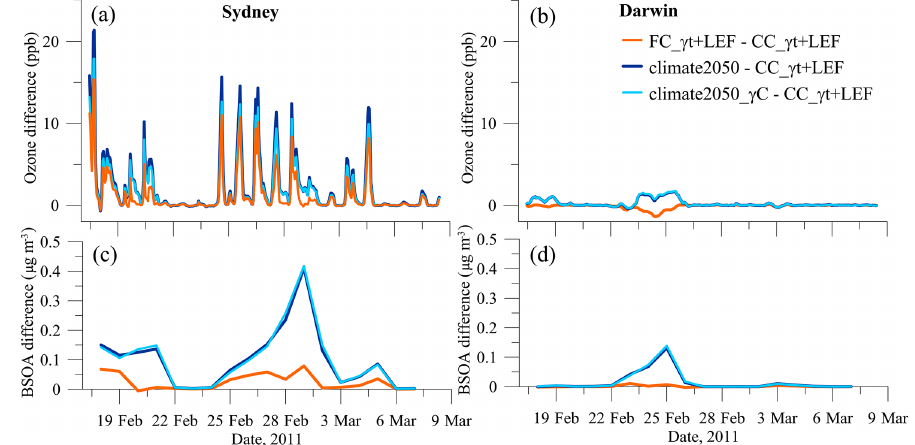
Figure 6. Differences in hourly ozone (a, b) and biogenic secondary organic aerosol (c, d) due to three 2050 experiments at Sydney and Darwin during the SPS1 campaign